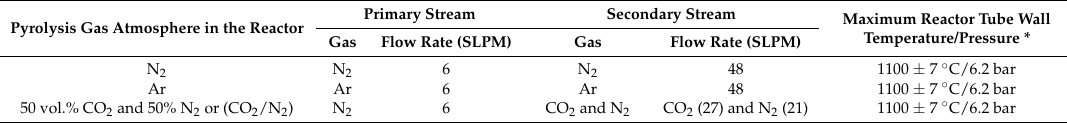
Table 2. Experimental conditions.